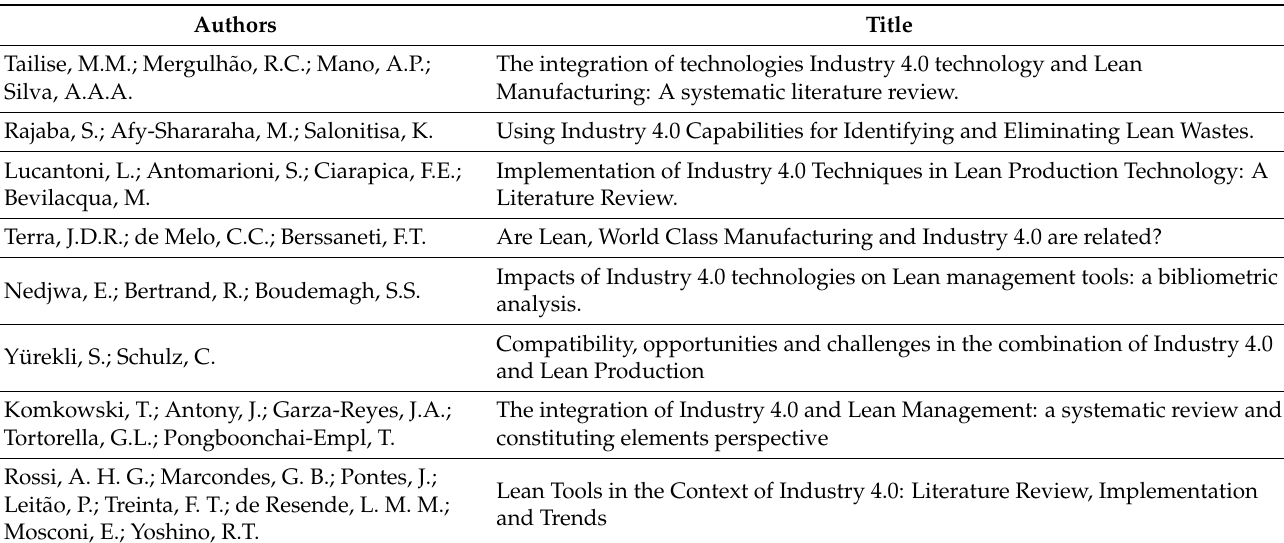
Table 1. Articles published in 2022—“Lean” and “Industry 4.0” literature